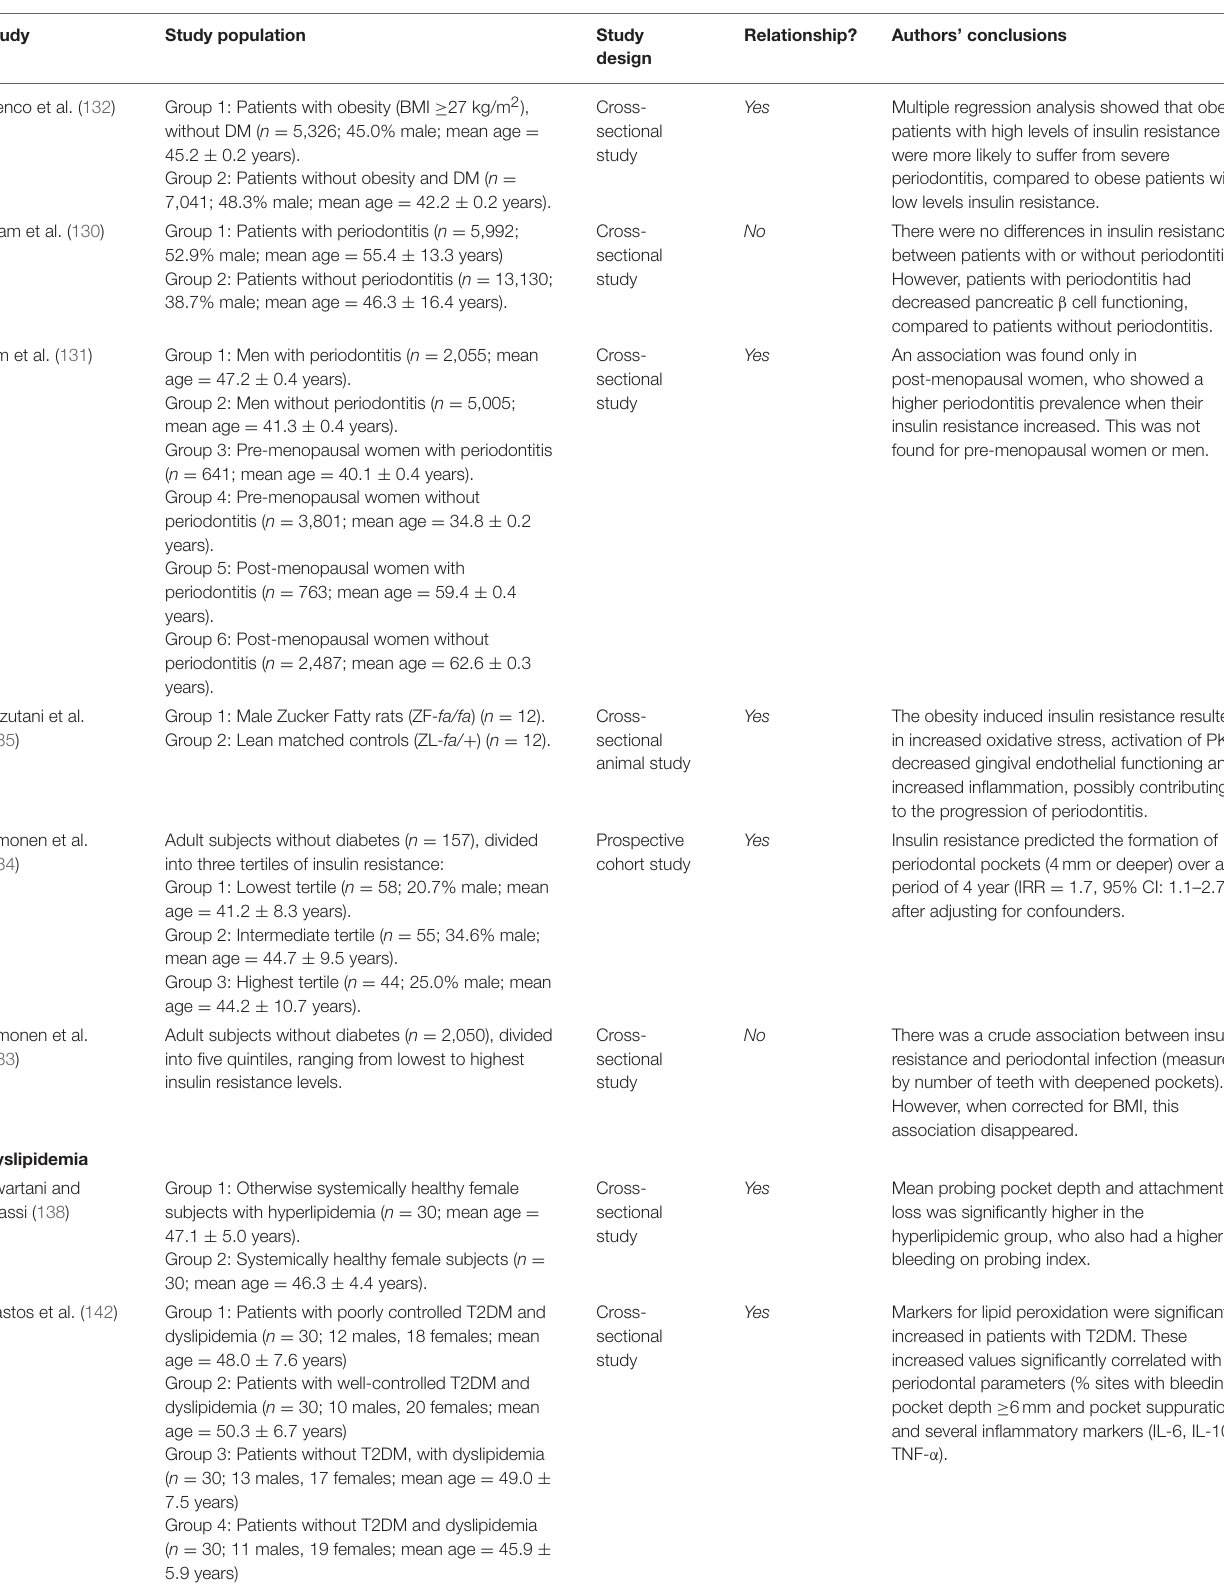
Cross- sectional study